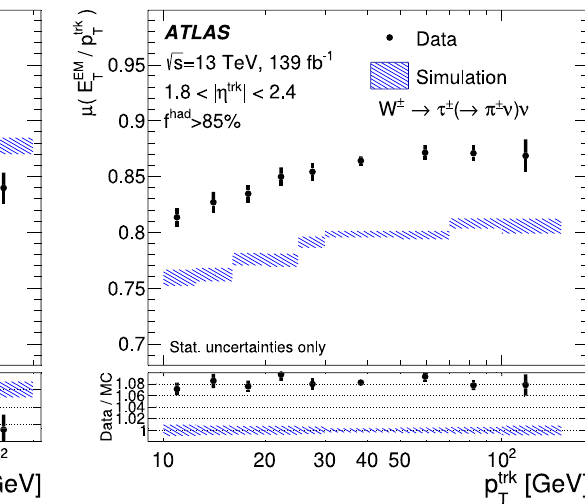
and uncertainty band show the uncertainties from the limited number of events in the dataset and simulated samples